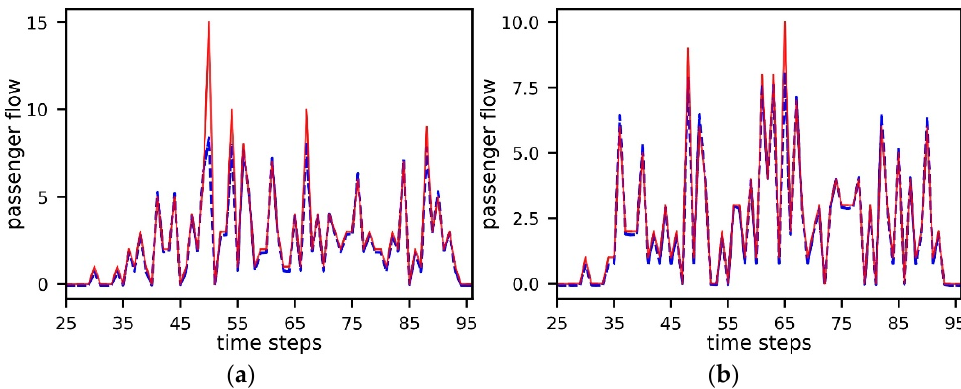
Figure 8. The examples of forecasting curves and the ground-truth curves for residential areas to CBD OD flow: ( a ) weekdays; ( b ) weekends.